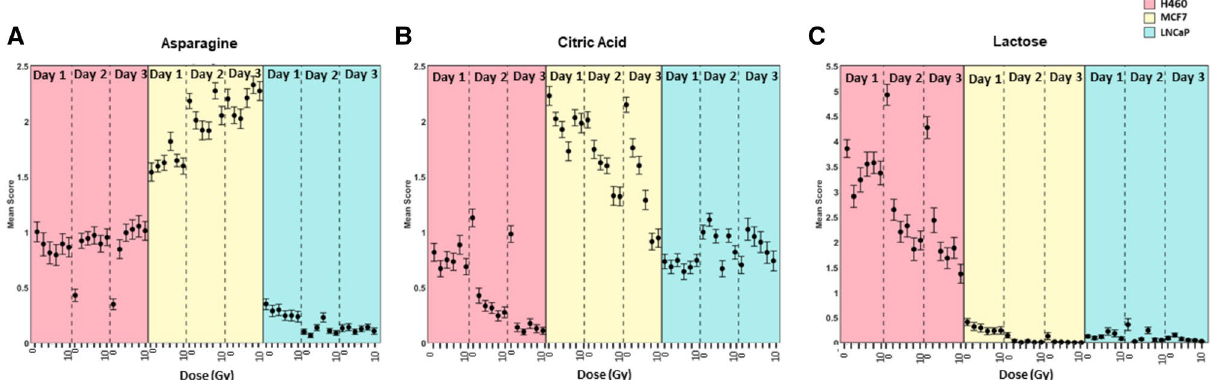
Figure 6. Mean scores obtained for H460 cells (pink), MCF7 cells (yellow) and LNCaP cells (blue) for doses 2–10 Gy on days 1–3 post irradiation for asparagine (A) , citric acid (B) and lactose (C) . Error bars represent + / − 1 standard